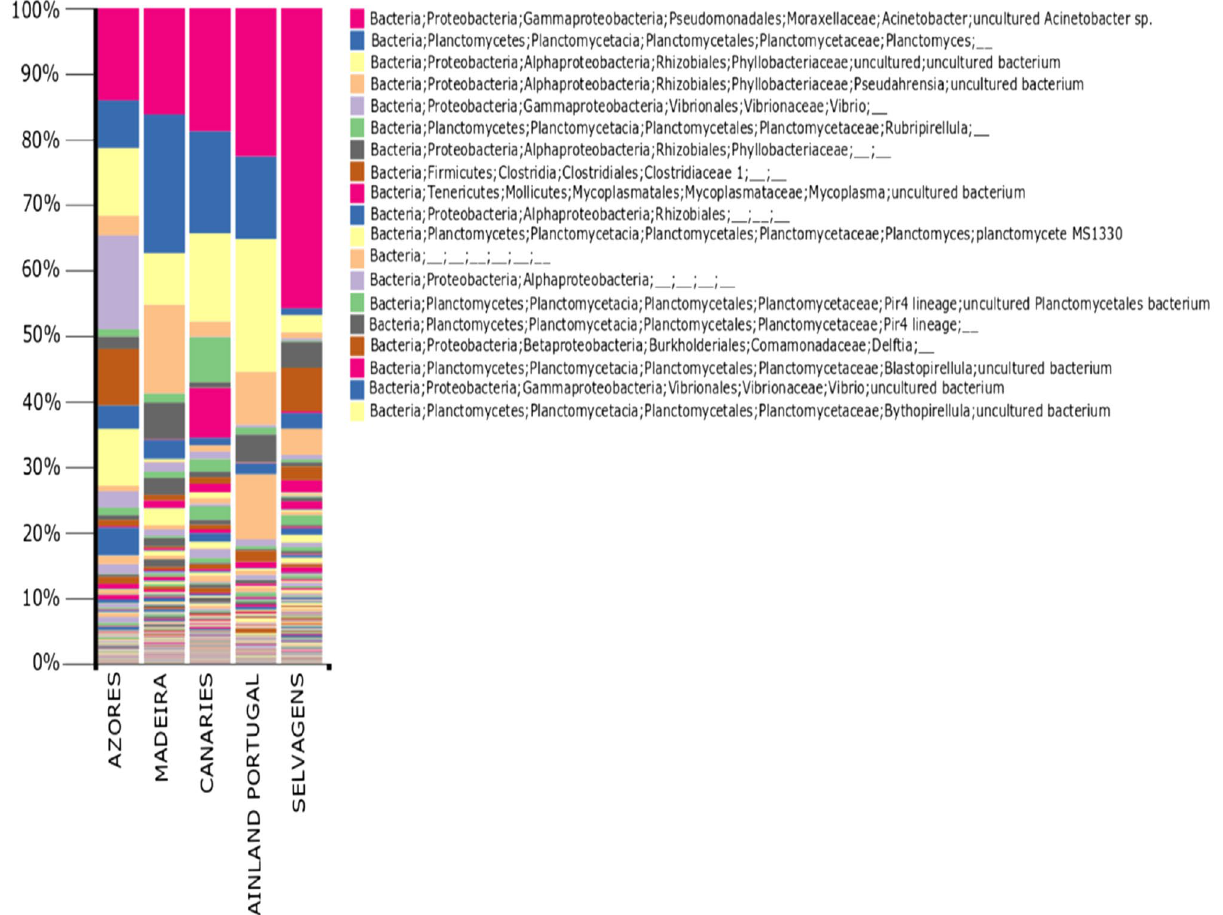
Figure 2. Operation Taxonomic Units (OTUs) at species level for endosymbiotic bacteria found in the mollusc Phorcus sauciatus from five coastal locations in the Atlantic Ocean (mainland Portugal and the islands of Madeira, Selvagens, Azores and the